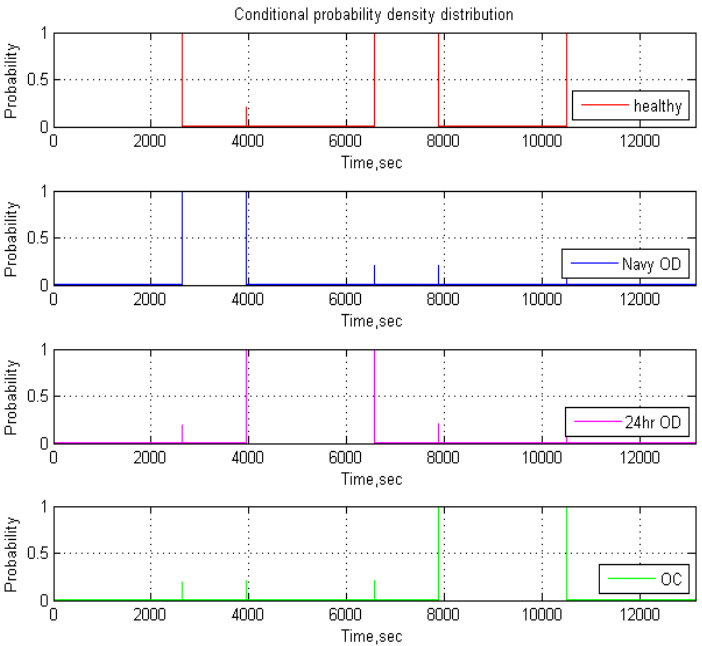
Figure 11. Conditional probability densities of respective battery operating conditions for R = 1 × 10 − 8 .